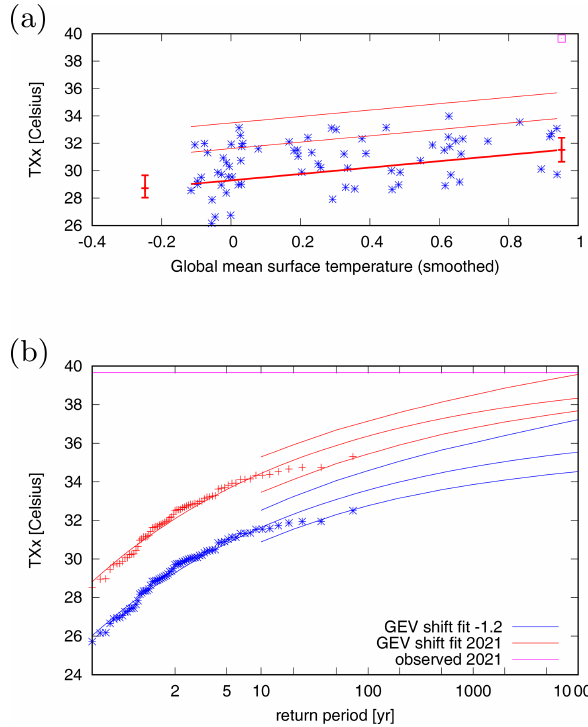
Figure 7. As Fig. 6, but demanding the 2021 event is possible in the fitted GEV function; i.e. the upper bound is higher than the value observed in